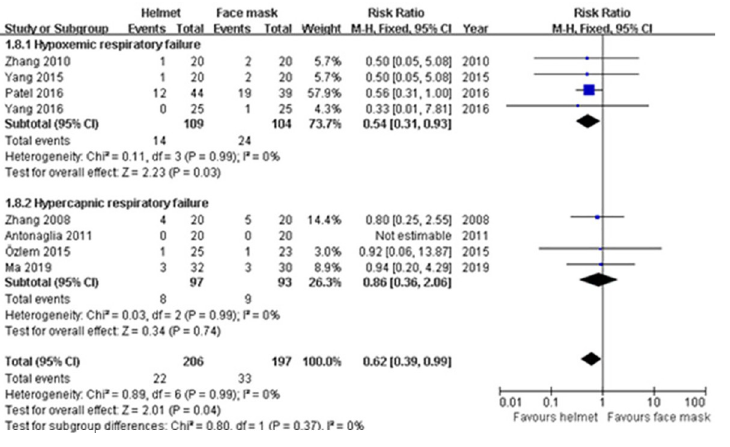
Fig 12. Forest plot of hospital